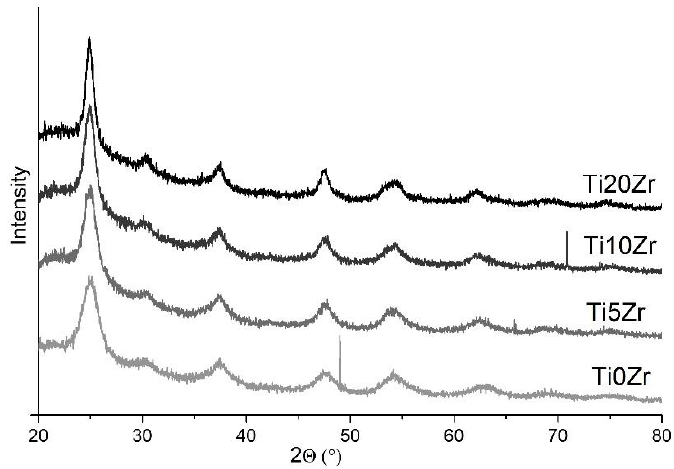
Figure 2. X-ray powder diffraction (XRD) powder patterns.